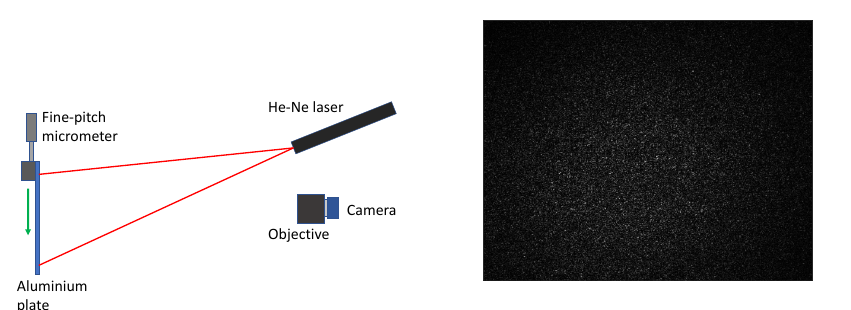
Figure 4. Sketch of the experimental set-up. The set-up consists of a 10 mW He-Ne laser, a monochrome camera from Dalsa equipped with a mikro-Nikkor camera objective with focal length f = 55 mm, and a white aluminum plate that can be translated in-plane using a fine-pitch micrometer. The right part of the figure displays one of the acquired speckle images. This image is acquired with an aperture setting of f /32.